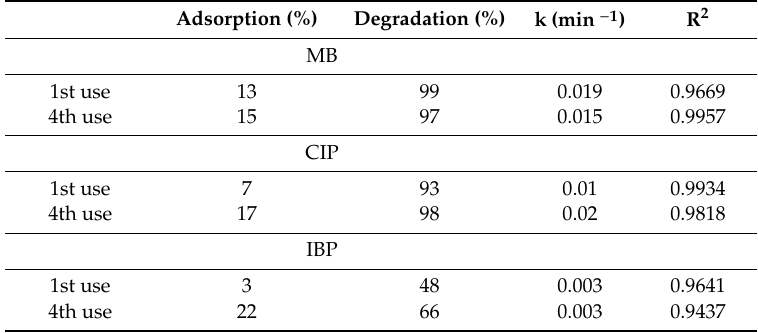
Table 1. Comparison of the photocatalytic degradation and reaction rate (k) of MB, CIP, and IBP by the TiO 2 / PVDF-TrFE microporous nanocomposite, according to the first and last use.